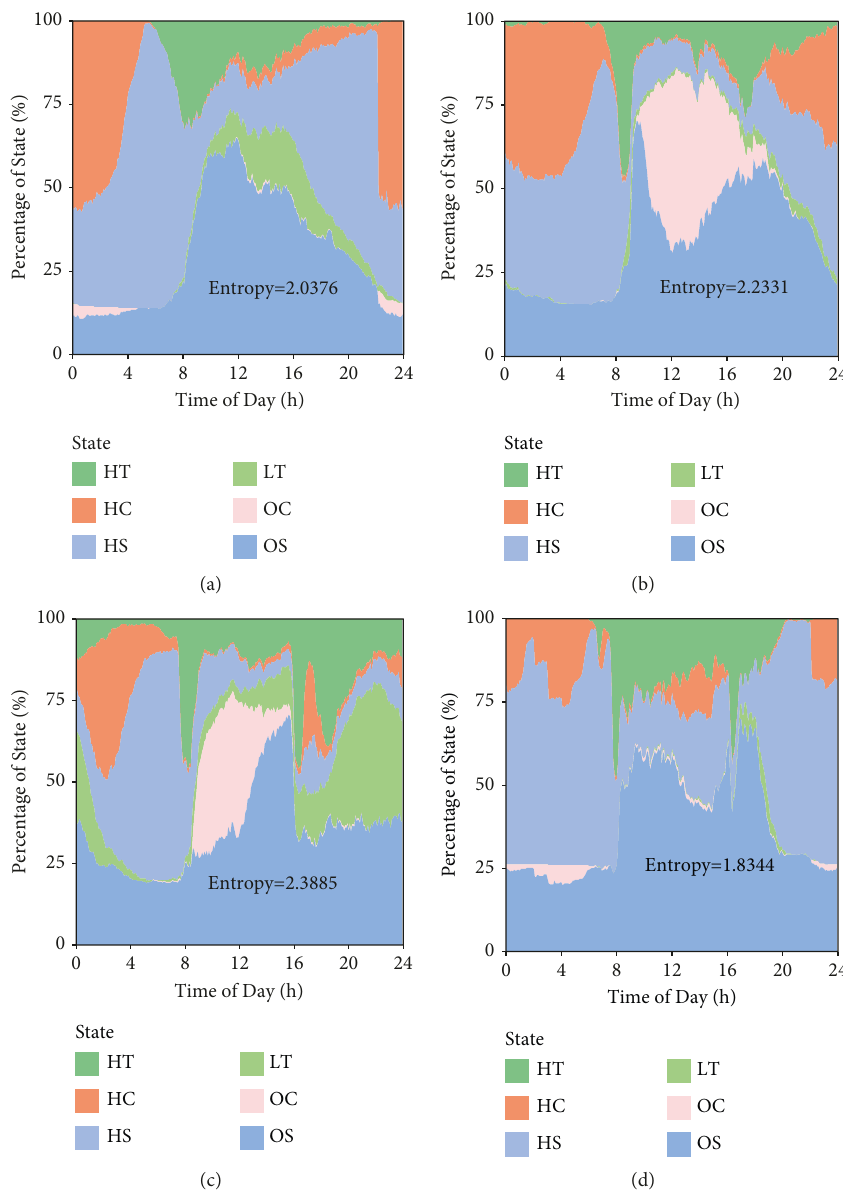
Figure 8. The prediction performances for all three models deteriorate slowly over the prediction length. It can be seen from Figure 8 that the Bi-GRU-Attention model outper- forms GRU and n-gram in terms of prediction accuracy for all considered scenarios, especially when the prediction length is long (i.e., 180 min). When the prediction length is